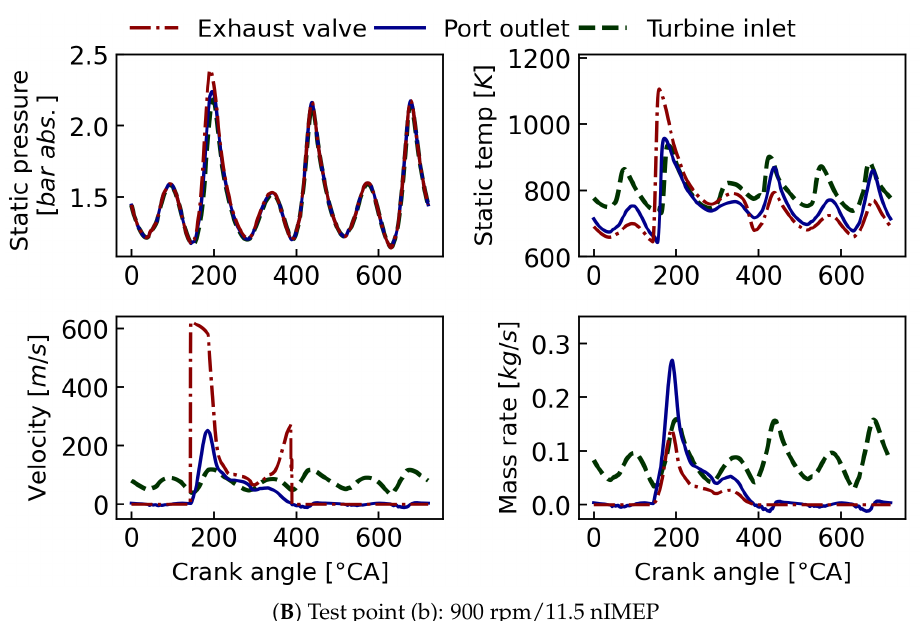
Figure A1. Exhaust flow conditions at three measurement locations operating at test